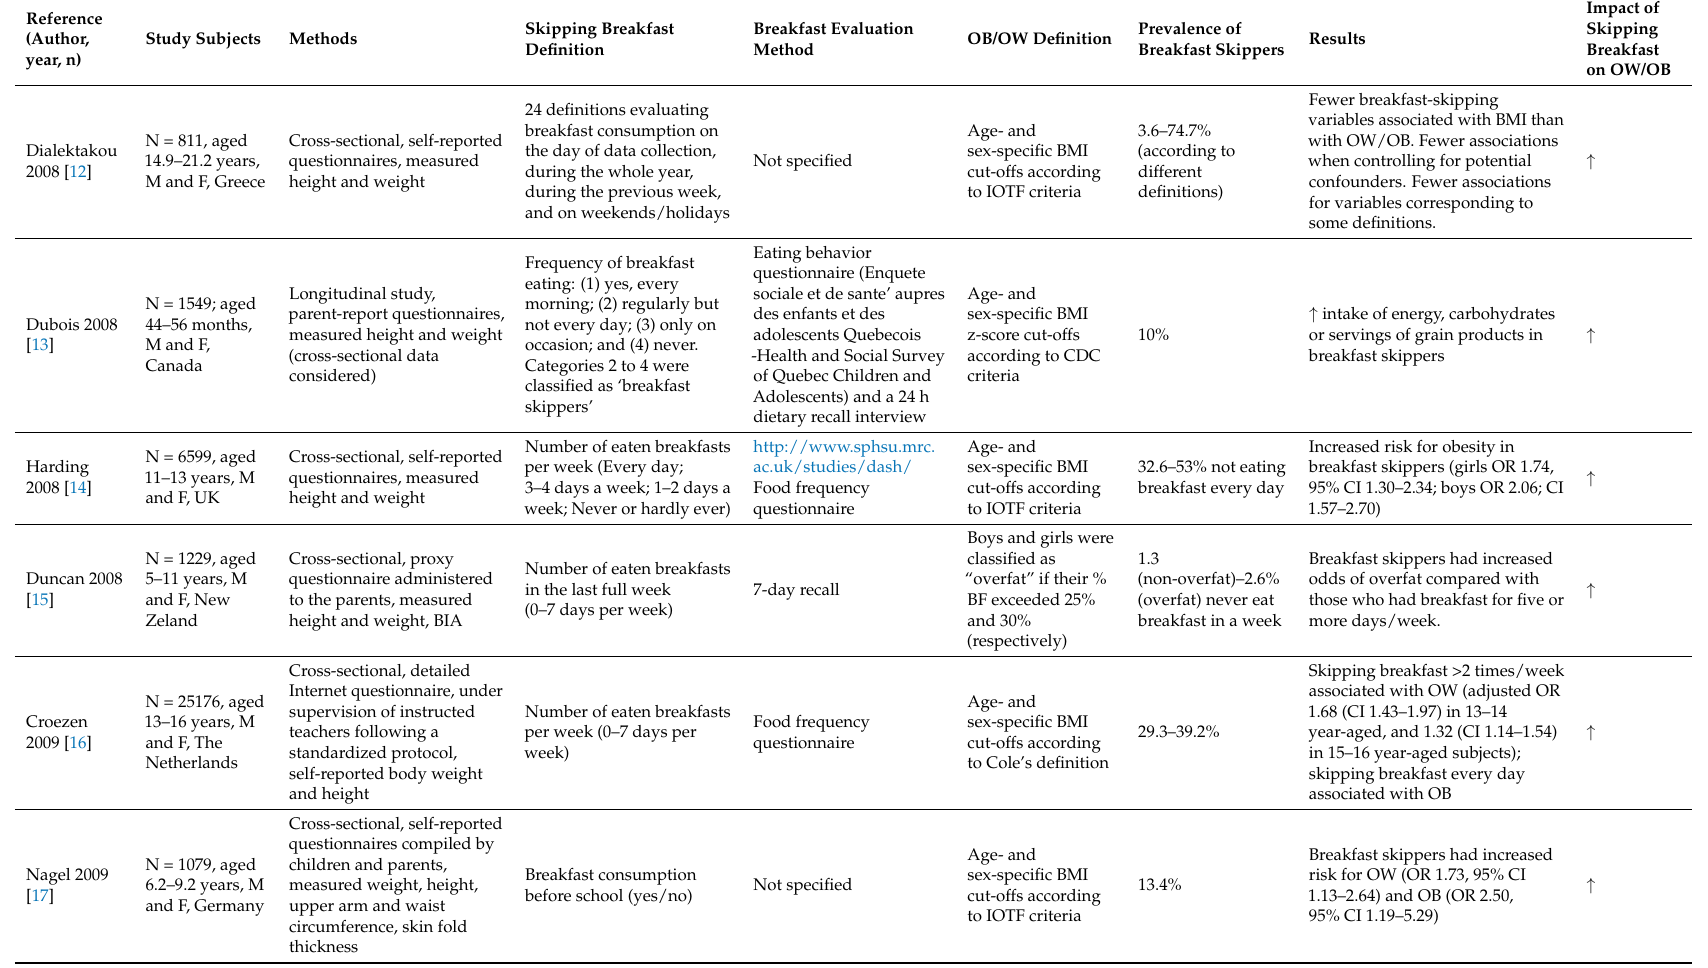
Table 1. Summarized studies’ characteristics on weight and skipping